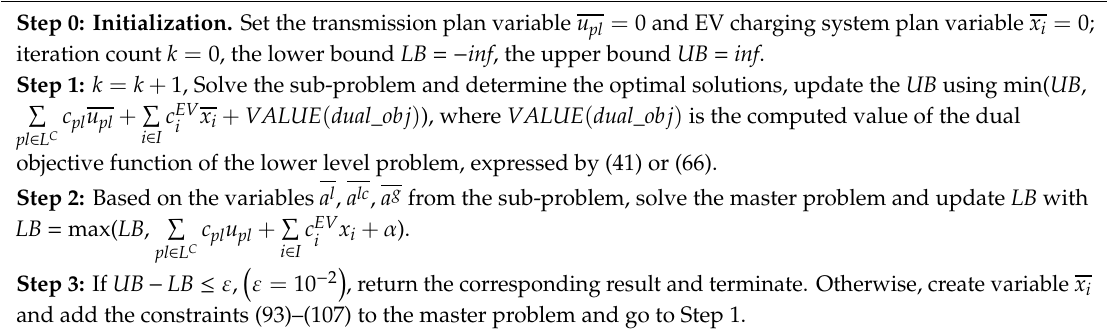
Solution Algorithm: Duality-based column and constraint generation (D-CCG)